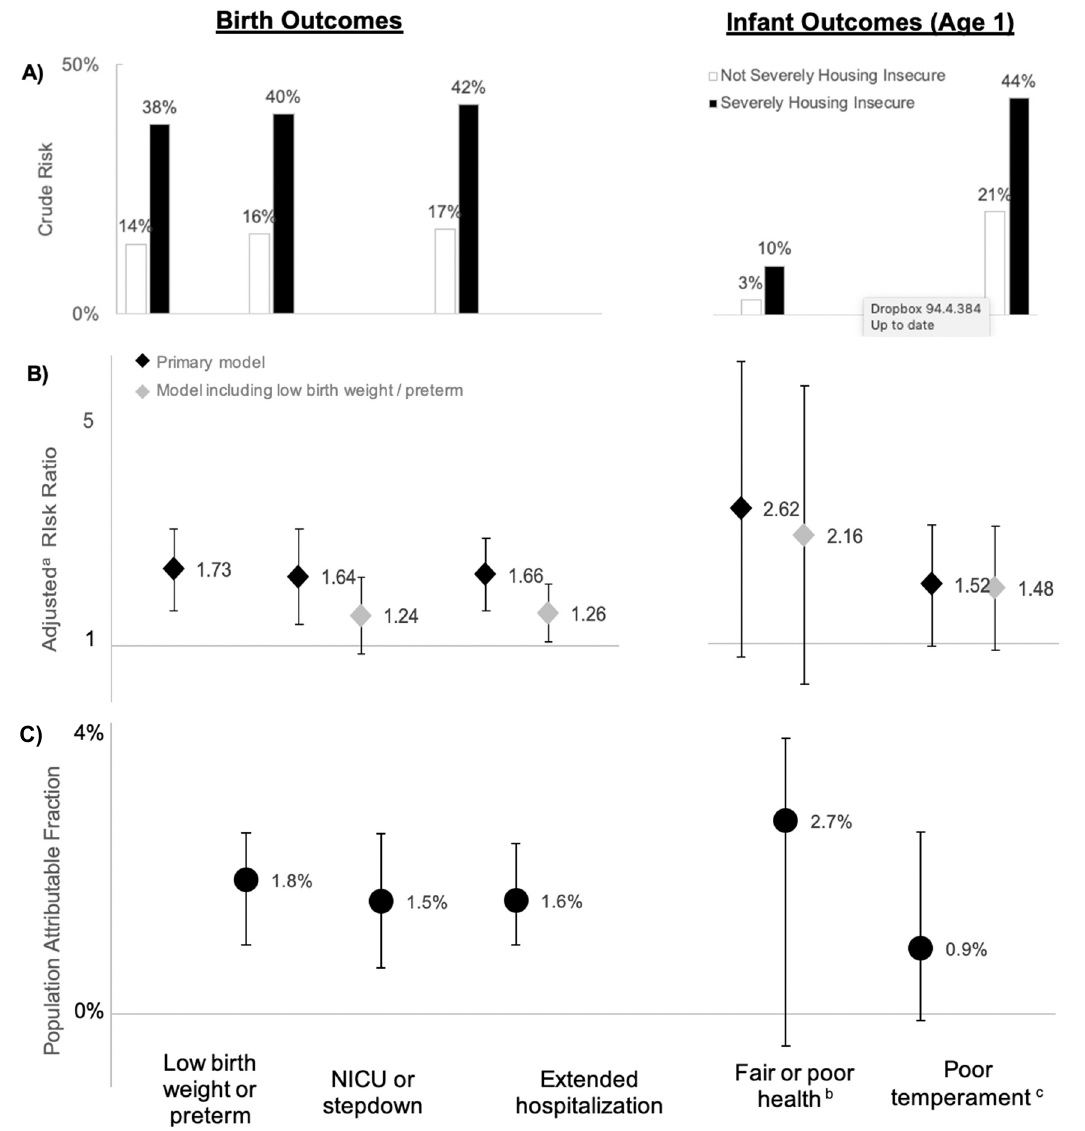
Figure 3. ( A ) Crude risk, ( B ) adjusted risk ratios, and ( C ) population attributable fraction of birth and infant outcomes associated with severe housing insecurity during pregnancy, the Fragile Families and Child Wellbeing Study, 1998–2000. a Covariates include maternal age category, race / ethnicity, poverty level, education, marital status, pre-pregnancy mental health status, preexisting conditions (hypertension, renal disease, diabetes, lung disease, heart disease, and / or anemia), and infant sex. b > 2 days for vaginal births, > 4 days for cesarean births. c Scoring in topmost quintile of a scale constructed from the emotionality subscale of the Emotionality, Activity, and Sociability (EAS) Temperament Survey for Children.